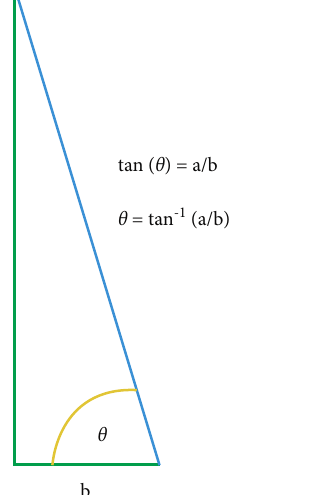
Figure 6: Measurement of contact from the gradient of the tangent of the slope to the baseline.